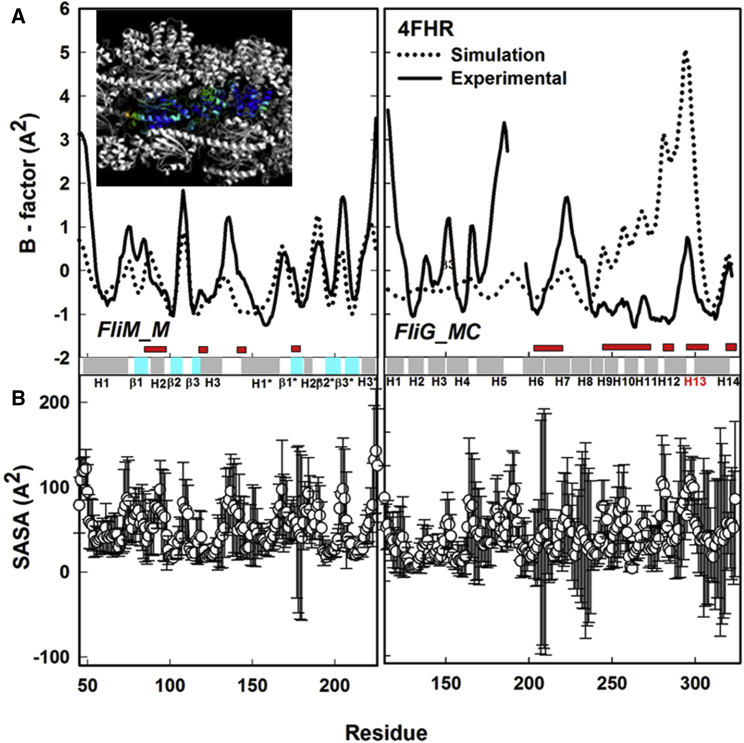
Residue Fluctuations in FliMMFliGMC(A) Experimental B-factor values (solid line) compared with simulated values (dotted line). The B factors were normalized. B = ((Bres − Bmean)/σB), where Bmean and σB are mean and SD, respectively, of the simulated B-factor (Bres) distribution. Parameters in later figures are normalized similarly. Red bars denote residues in contact with neighboring complexes in the crystal. FliMM Pcorr = 0.63. FliGMC Pcorr = (−0.2 [overall]; 0 [non-contact N-terminal]). Inset: PDB: 4FHR unit cell (B factor high = orange; intermediate = green/cyan); low = blue) and neighboring complexes (white). H13 = TH.(B) Residue SASA (mean [open circles] ± σ). Horizontal bar shows secondary structure elements: α helices (gray), β sheet (cyan), loops (white).